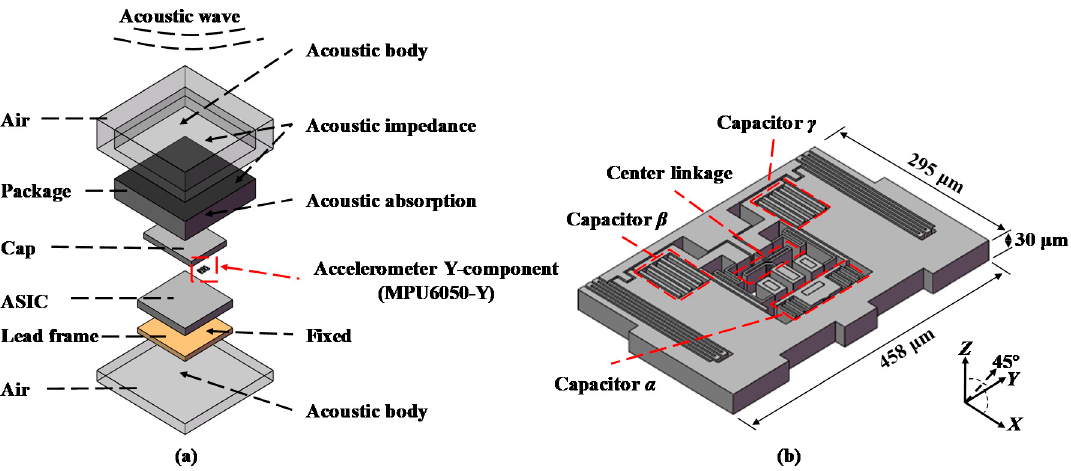
Figure 5. ( a ) Schematic of the MPU6050 model; ( b ) geometric model of MPU6050-Y.